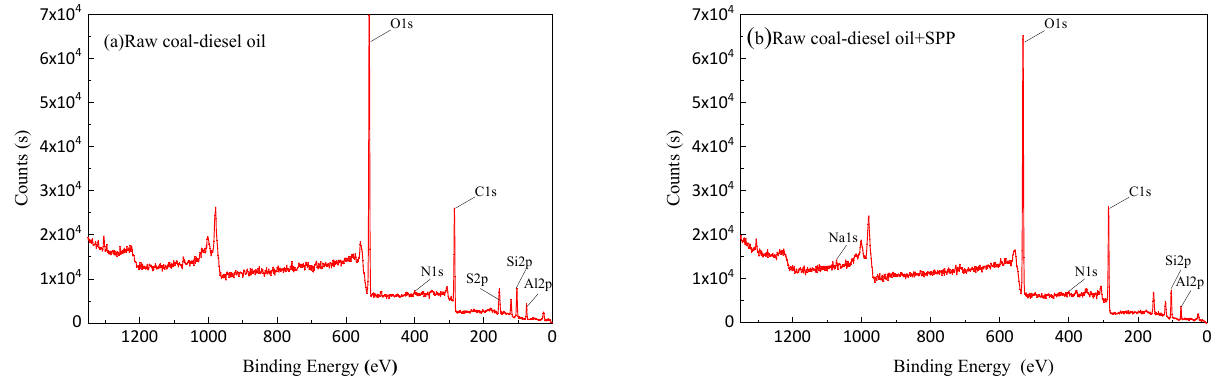
Figure 7. XPS wide spectrum of coal samples with different conditions: ( a ) coal was treated with diesel oil; ( b ) coal was treated with diesel oil and SPP.